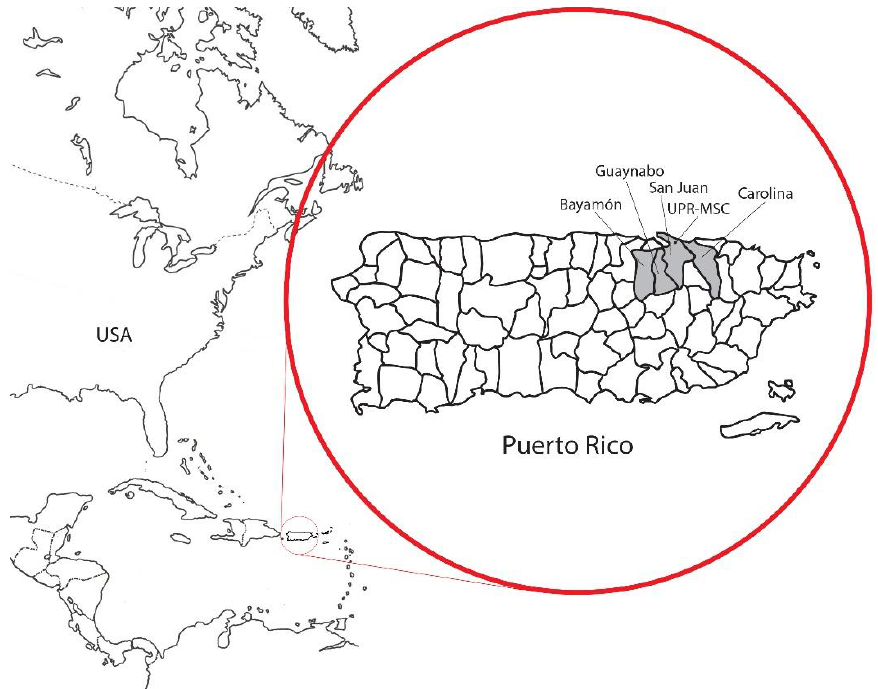
Figure 1. Geographical Location of Targeted Municipalities in the Atabey Study, Puerto Rico.